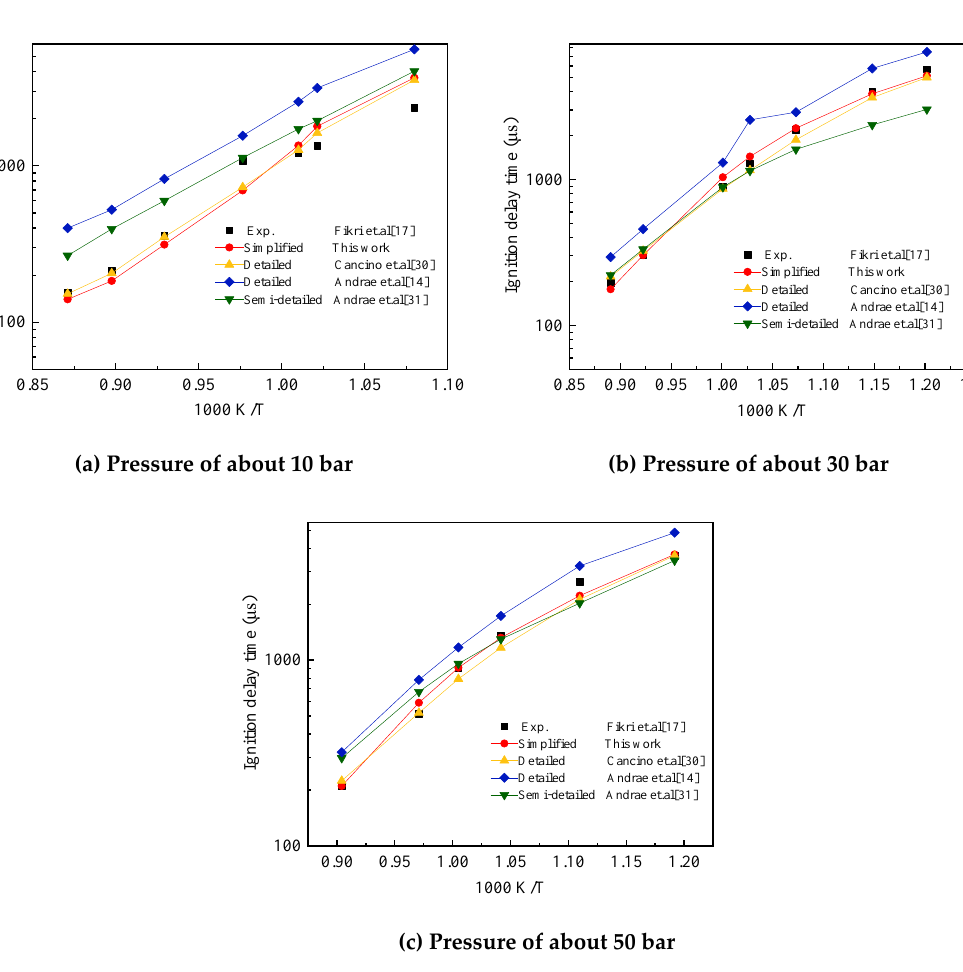
Figure 12. Comparison of experimental and the five-component gasoline surrogate fuel (TDRF) mechanism validation results on ignition delay times. Pressures of about ( a ) 10, ( b ) 30 and ( c ) 50